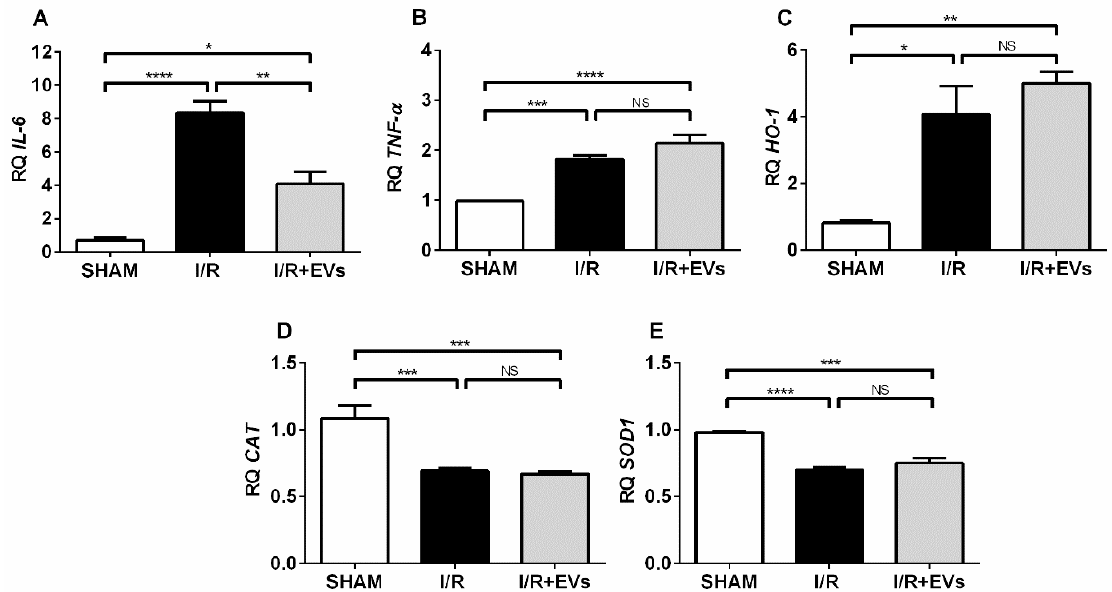
Figure 7. Expression of pro-inflammatory cytokines and antioxidant enzymes, of which expression was investigated from the total RNA extracted from cortex corticis. ( A ) IL-6 . ( B ) TNF- α . ( C ) Heme oxygenase-1 . ( D ) Catalase . ( E ) Superoxide dismutase-1 . Bars represent mean ± SEM that were compared using one-way ANOVA followed by Tukey’s test. Groups are indicated on the abscissae; n = 4 (SHAM), n = 7 (I/R), n = 5 (I/R+EVs). * p < 0.05; ** p < 0.01; *** p < 0.001; **** p < 0.0001; NS: not significant.